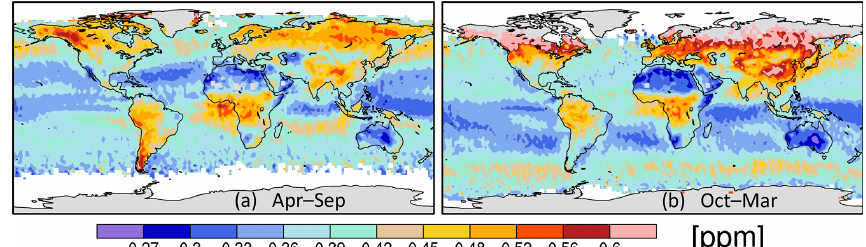
Figure 7. The uncertainty [ppm] in the 2s average X CO values given by the constant correlation model using the information-based weights 2 (Eq. 42) and the half-correlation lengths (see text) for (a) April–September and (b)